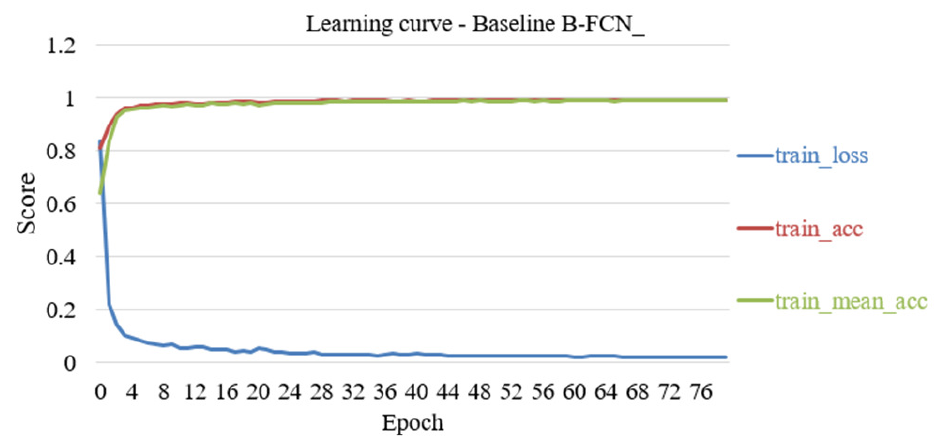
Figure 4. Baseline B-FCN iterative 80 times training results.